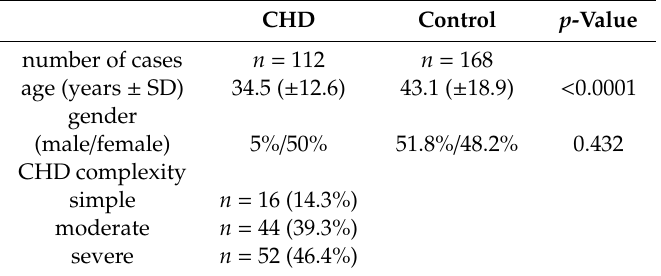
Table 1. Of study groups; p -values as obtained with Mann–Whitney and Fisher’s exact test; complexity of CHD according to Bethesda